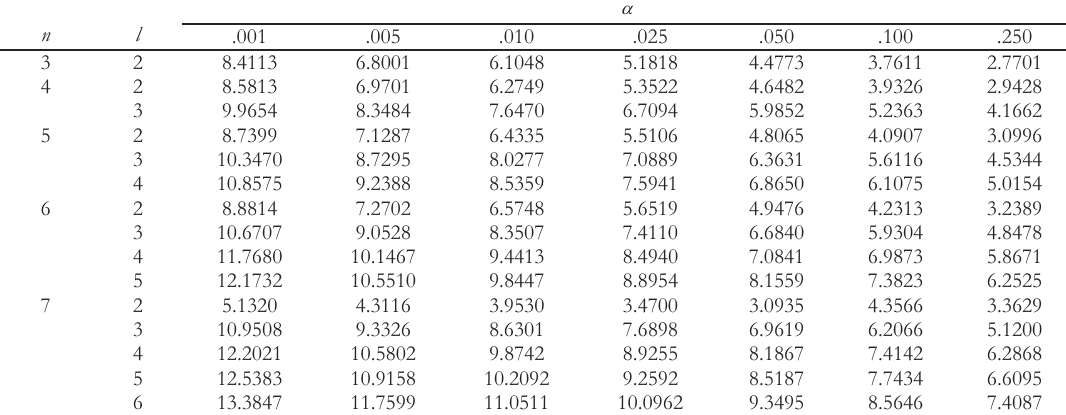
Critical values for Test 2 with SRSS data from the exponential distribution